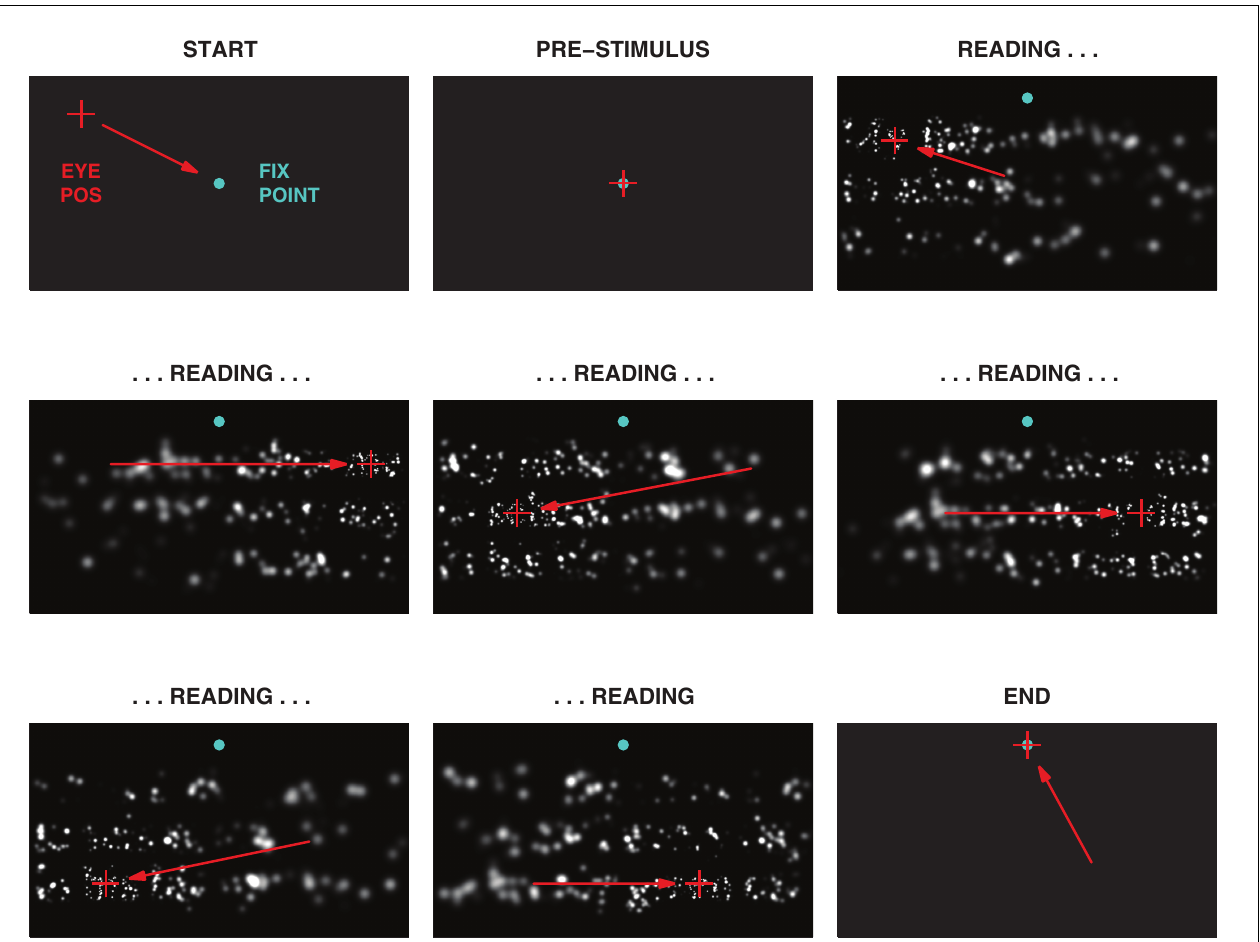
FIGURE 5 | Phases of the experimental task. One trial of the task is shown in a sequence of snapshots. The task had four distinct phases, Start, Pre-Stimulus, Reading, and End, with the bulk of the time spent in the Reading phase. Green-blue dots indicate the initial central fixation point used to engage the trial, and the subsequent dot at the center top used to advance to the next trial. Red crosses indicate the instantaneous gaze position, and red arrows, the gaze motion from one